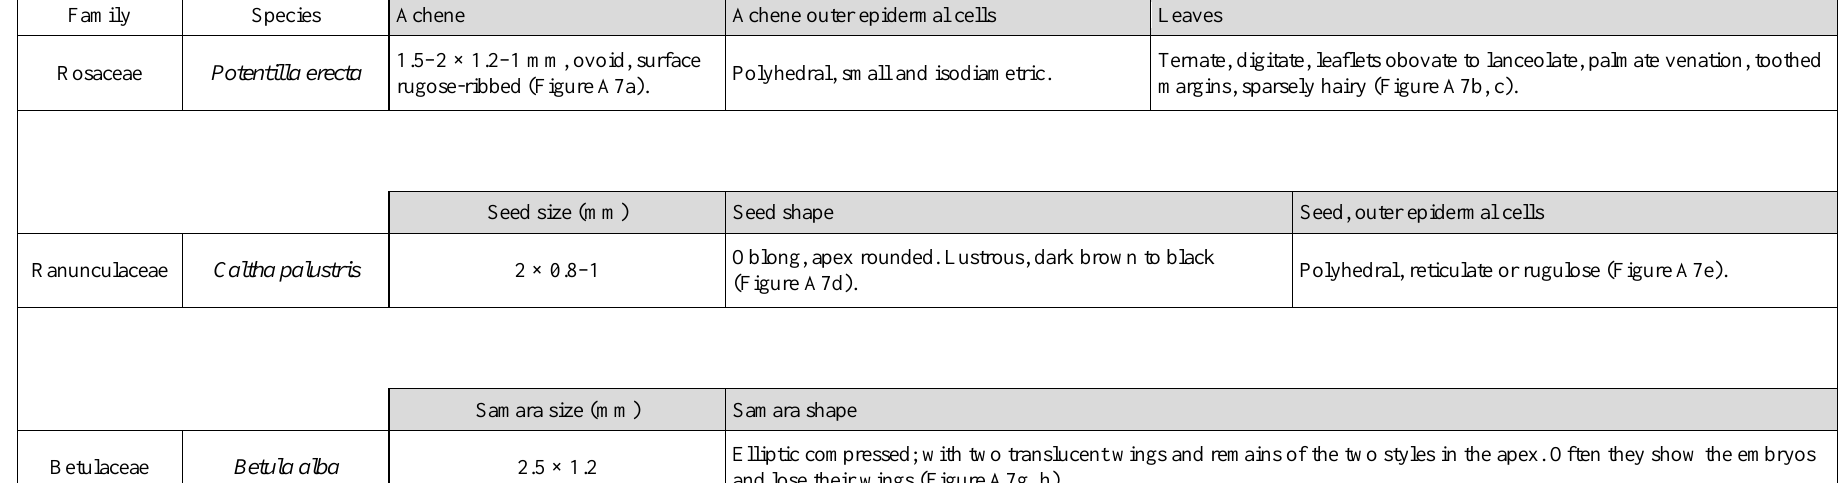
Elliptic compressed; with two translucent wings and remains of the two styles in the apex. Often they show the embryos and lose their wings (Figure A7g,